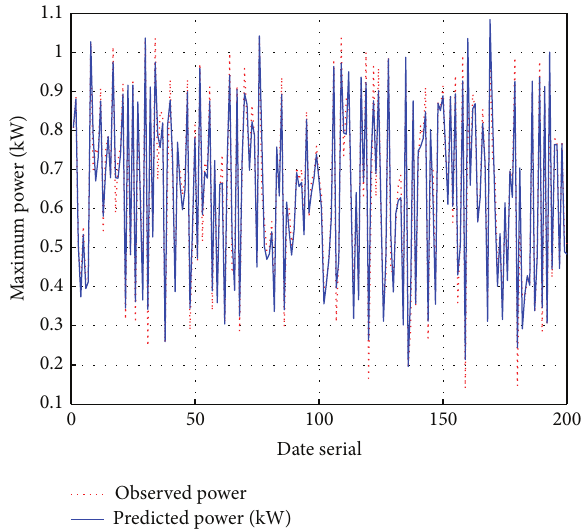
signal is written into the output unit for times 𝑛 = 1, . . . , 800 . The internal states 𝑥(𝑛) = (𝑥 1 (𝑛), . . . , 𝑥 20 (𝑛)) for 𝑛 = 1, . . . , 800 are collected as a row of a state-collecting matrix M of size 800 × 20 during the sampling period. At the same time,